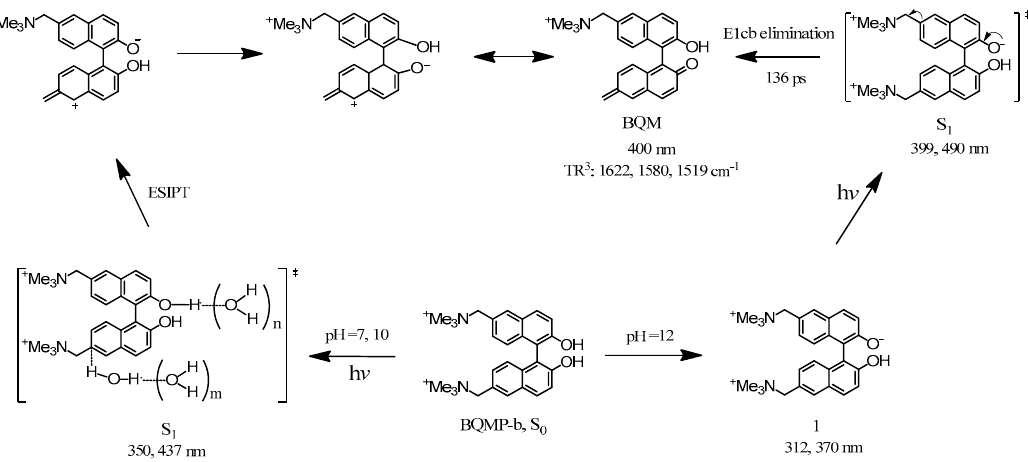
Scheme 4. Proposed reaction mechanism for BQMP-b based on the results from the time-resolved